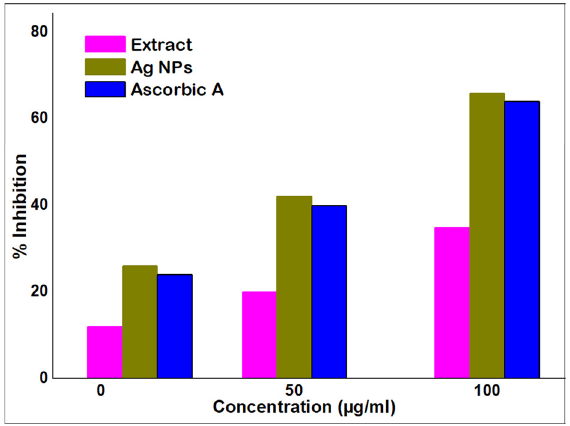
Figure 7: DPPH free radical scavenging activity of prepared